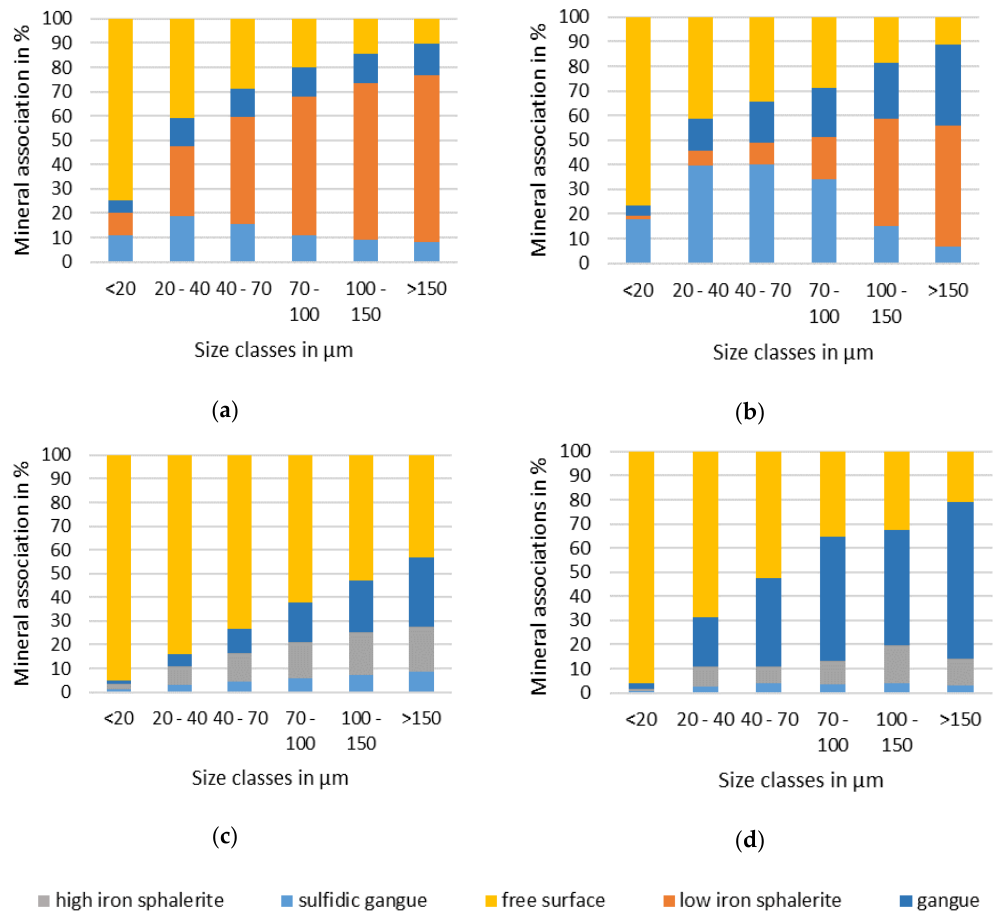
Figure 8. Mineral associations in concentrates ( a , c ) and tailings ( b , d ) for high ( a , b ) and low iron sphalerite ( c , d ).